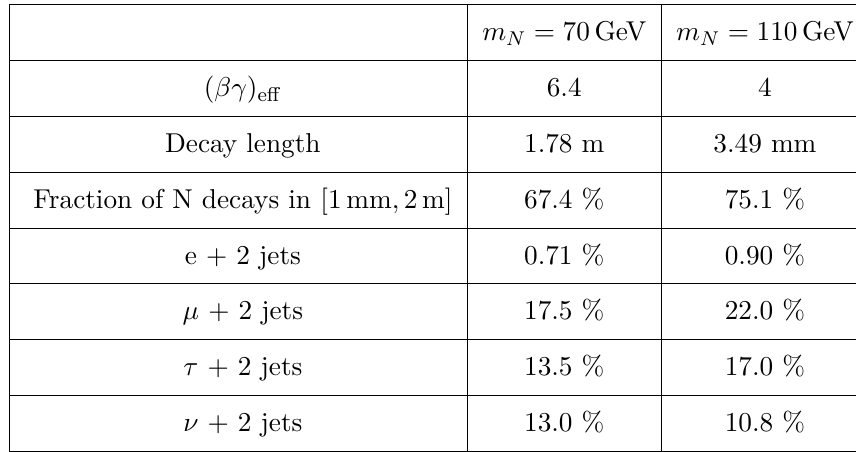
Table 2 . Percentage of sterile neutrinos decaying to the final states l + 2 jets ( l = e, µ, τ ) and ν + 2 jets between 1 mm and 2 m from the production point, for m N = 70 GeV and 110 GeV and in the maximal mixing case. The other model parameters are chosen as in table 1. Also shown are the value of the ( βγ ) eff parameter, estimated as explained in the text, the sterile neutrino decay length and the total fraction of decays occurring between 1 mm and 2